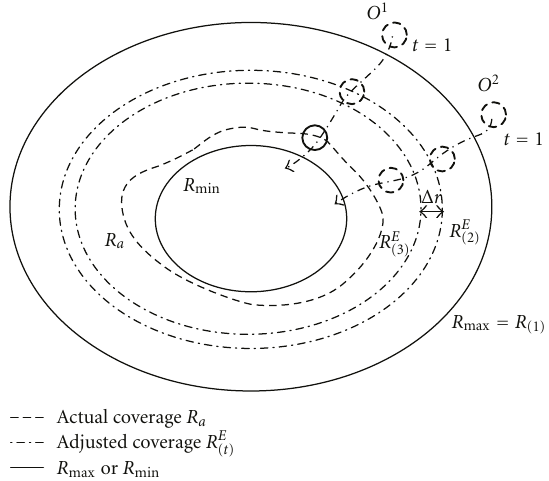
Figure 8: Illustration of coverage reduction when objects leave the coverage of an identification sensor.